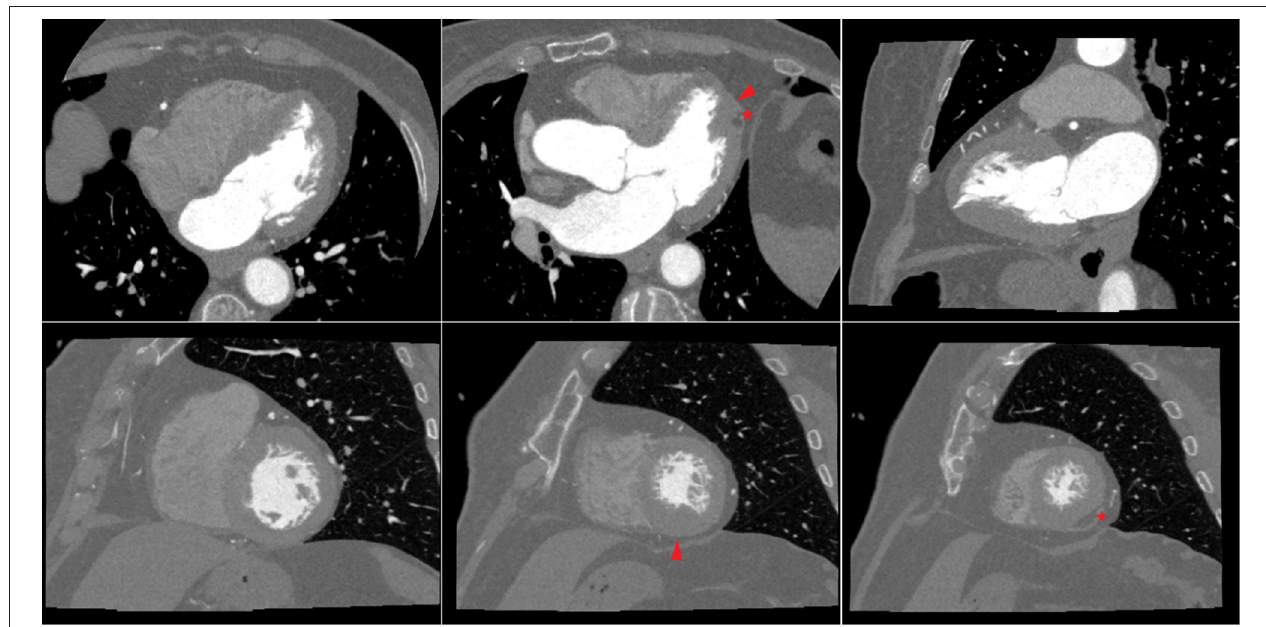
FIGURE 4 | Cardiac CT in a patient with dyspnea and apical hypertrophic cardiomyopathy (left ventricular long-axis views, top row; left ventricular short axis views, bottom row). A 79-year-old woman with hypertension was referred to the cardiology clinic because of dyspnea. Clinical examination was unremarkable. Resting ECG showed anterior T wave inversion. A cardiac CT ruled out obstructive coronary artery disease, while showing hypertrophy (maximal wall thickness 15mm at end-diastole) of the inferior and lateral apical segments, and of the inferior mid-ventricular segment (arrowhead). Moreover, there was fatty infiltration in the apical lateral segment (asterisk). Patient was diagnosed with apical hypertrophic